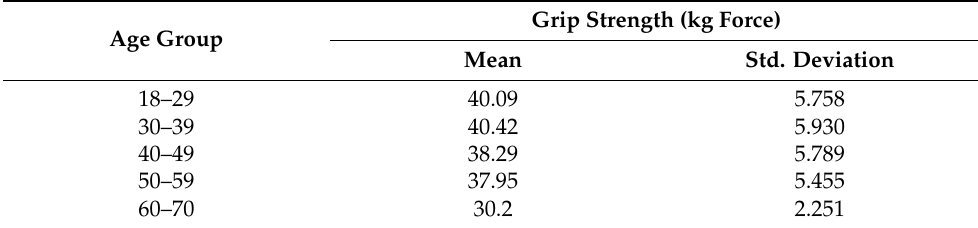
Figure 4. Effect of the age group on the grip strength of the male (* means there is a significant difference between levels). Table 4. Summary of males’ grip strength